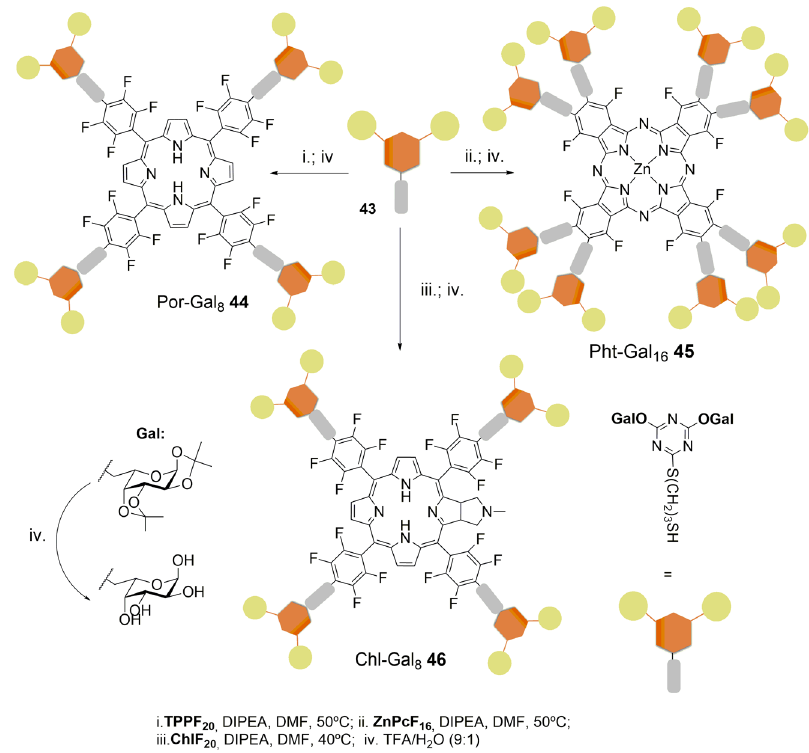
Figure 36 - Schematic representation for the synthesis of Por-Gal Chl-Gal 46 . 8